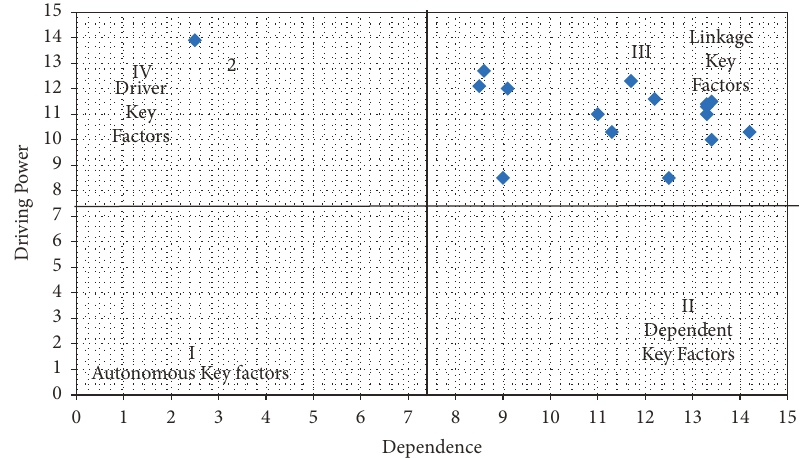
Figure 3: Diagram of Fuzzy MICMAC on dependence and driving powers of